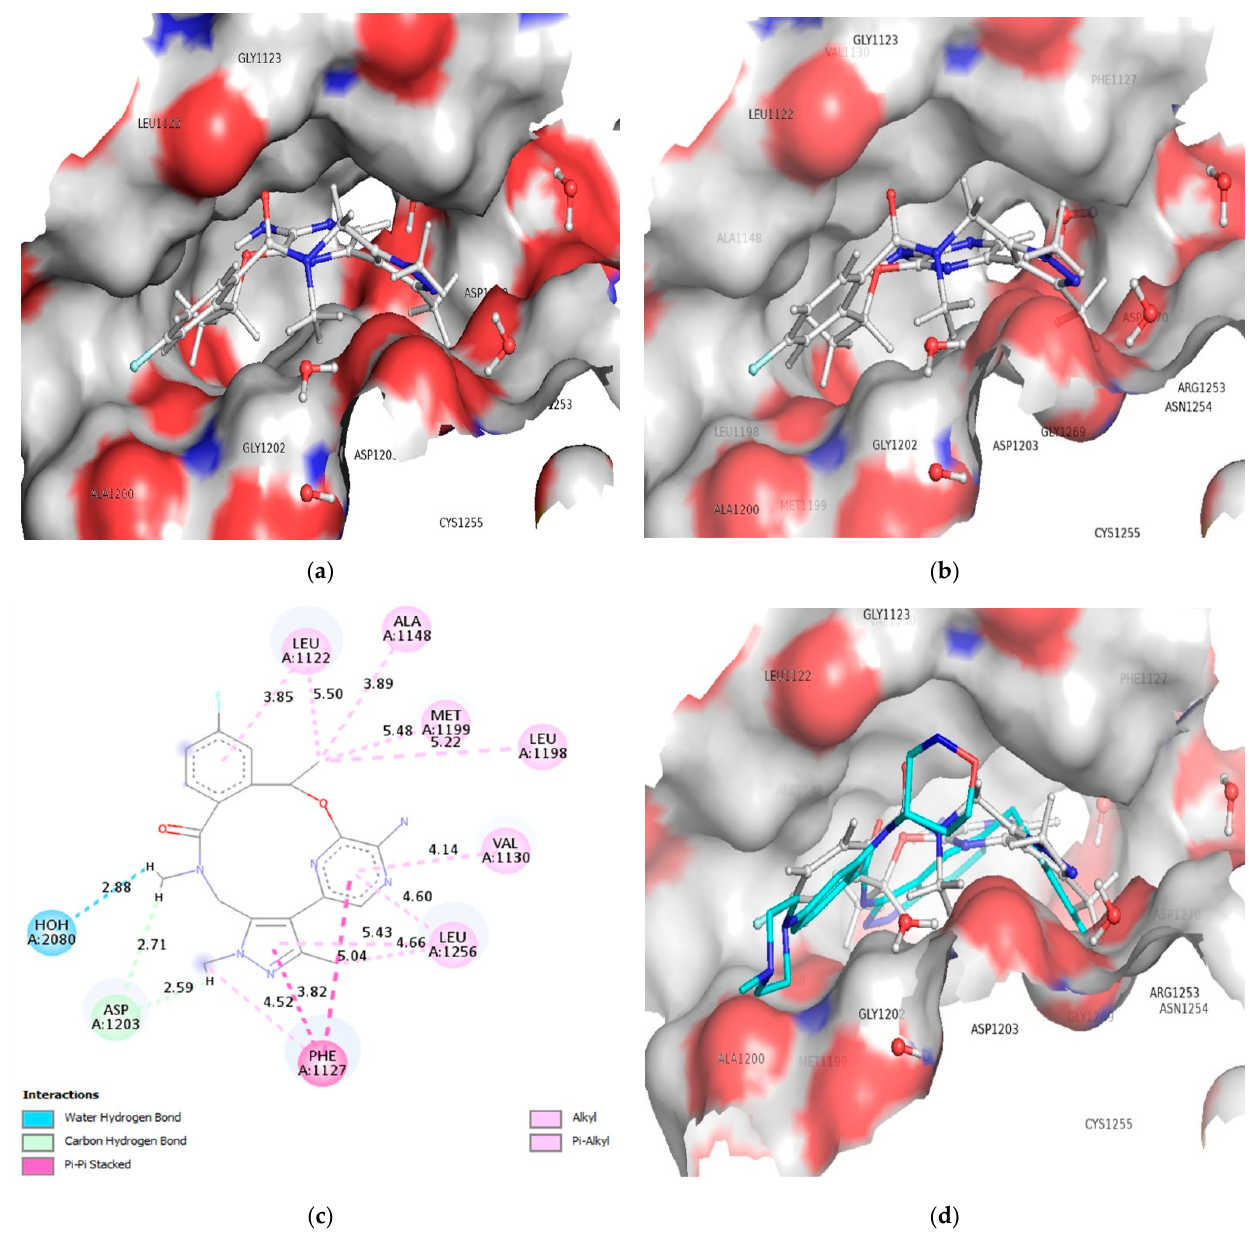
Figure 8. Depiction of alignment of compound 178 within the active site of ALK tyrosine kinase ( a , b ), 2D interaction of compound 178 with ALK tyrosine kinase ( c ), and Superimposed conformation of compound 178 with the pdb-5fto ligand (cyan colored): Entrectinib ( d ). Interestingly, the two pi-pi stacking hydrophobic contact into the drug receptor com- plex has been sustained and facilitated by the involvement of pi electrons from the pyra- zine ring, pyrimidine ring, as well as pi electrons from the saturated benzene ring in resi- due A: PHE1127 (Interatomic distances 5.03 and 3.82 Å resp.). As a result, the residues A: ALA1148 (Interatomic distance 3.88 Å), A: LEU1122 (Interatomic distance 5.49 Å), A: LEU1198 (Interatomic distance 5.22 Å), and A: MET1199 (Interatomic distance 5.47 Å) es- tablish an alkyl hydrophobic contact with the cyclononaphane ring’s C4 substituted me- thyl moiety. Furthermore, the pi electrons of the benzene ring at residue A: PHE1127 (in- teratomic distance 4.51 Å) establish pi-alkyl hydrophobic contact with the alky moieties